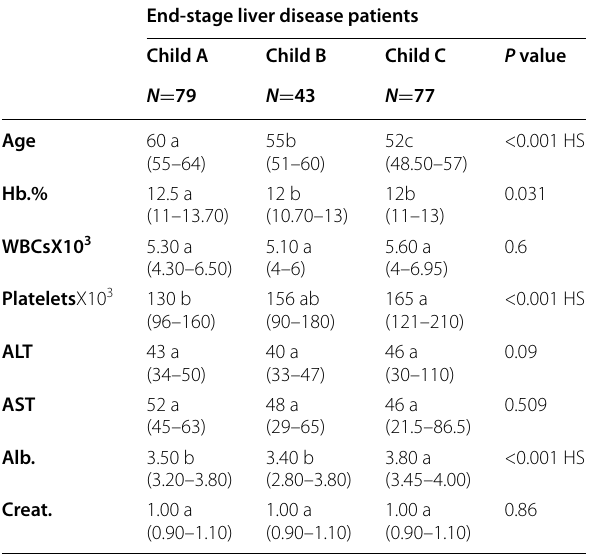
Table 2 Clinical data of the 199 end-stage liver disease (Child- Pugh class A, child B, and child